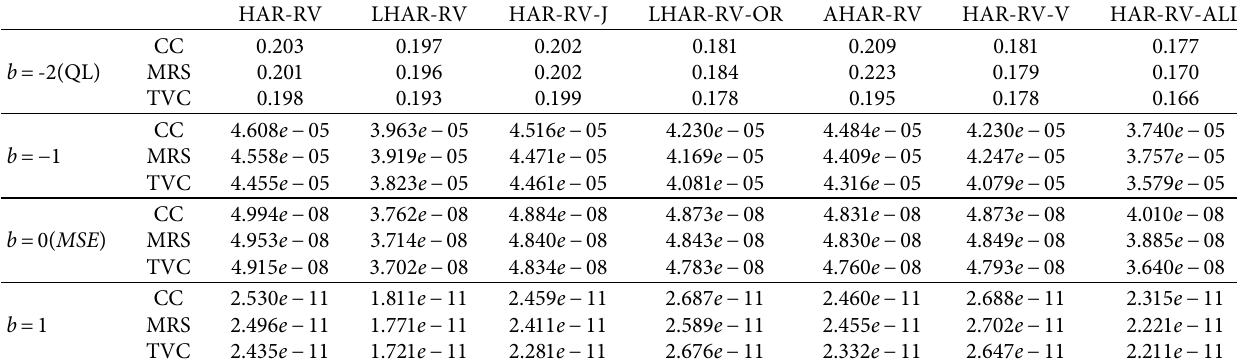
Table 3: Out-of-sample